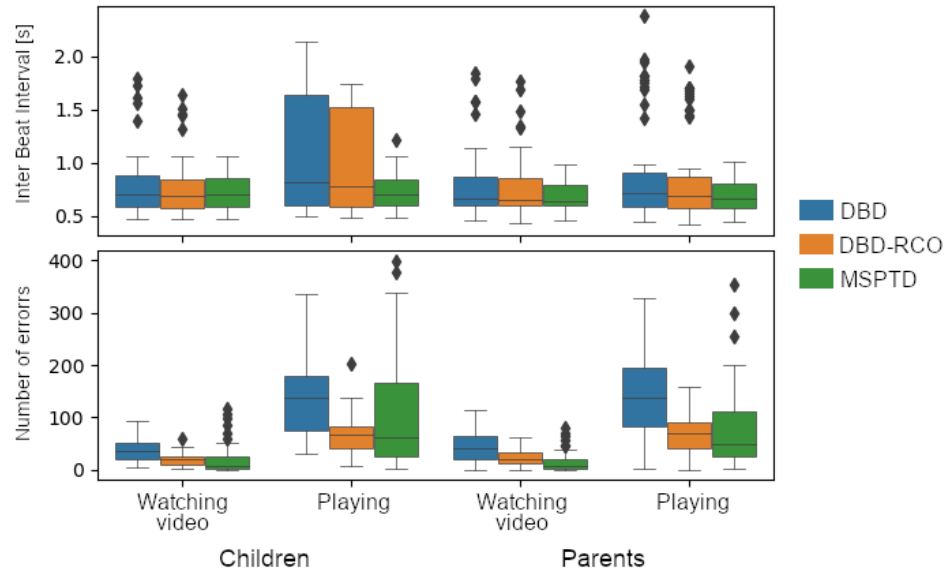
Figure 8. Results of the application of the heartbeat detection algorithms on the cardiac compo- nent signal derived from fNIRS data. ( Top ) distribution of the average InterBeat Interval length; ( Bottom ) distribution of the number of detection